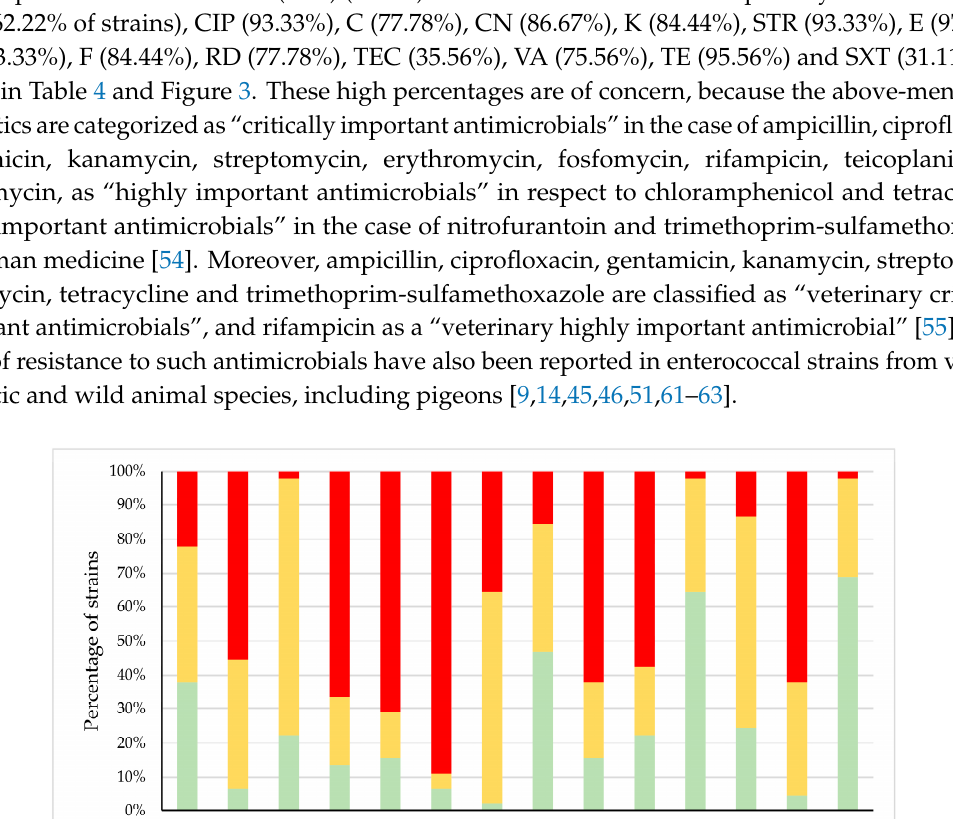
Table 4. Number and percentage of Enterococcus faecalis strains susceptible, intermediate or resistant to each antibiotic tested.